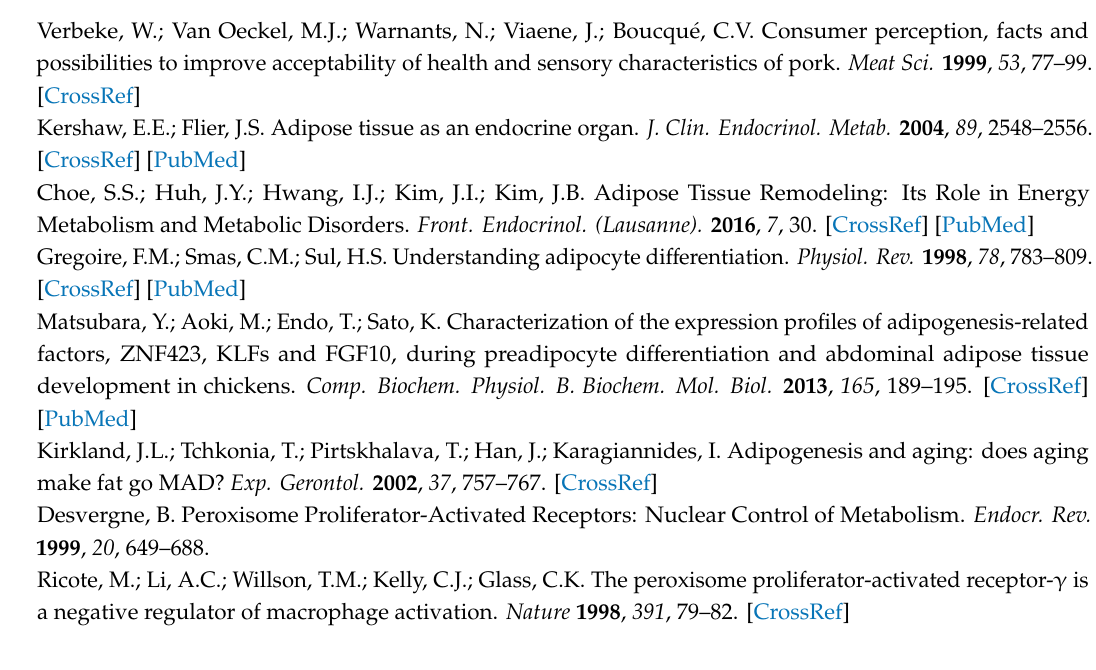
Table S1: PCR primers for qRT-PCR validation of eight genes involved in lipid metabolism; Table S2: Expression data of all genes, annotation and sequence of novel genes; Table S3: Di ff erentially expressed genes at days 2, 4, and 8 compared to 0 day; Table S4: Gene Ontology analysis of all di ff erentially expressed genes; Table S5: KEGG analysis of all di ff erentially expressed genes; Table S6: Gene Ontology analysis of all di ff erentially expressed genes in profiles; Table S7: KEGG analysis of all di ff erentially expressed genes in